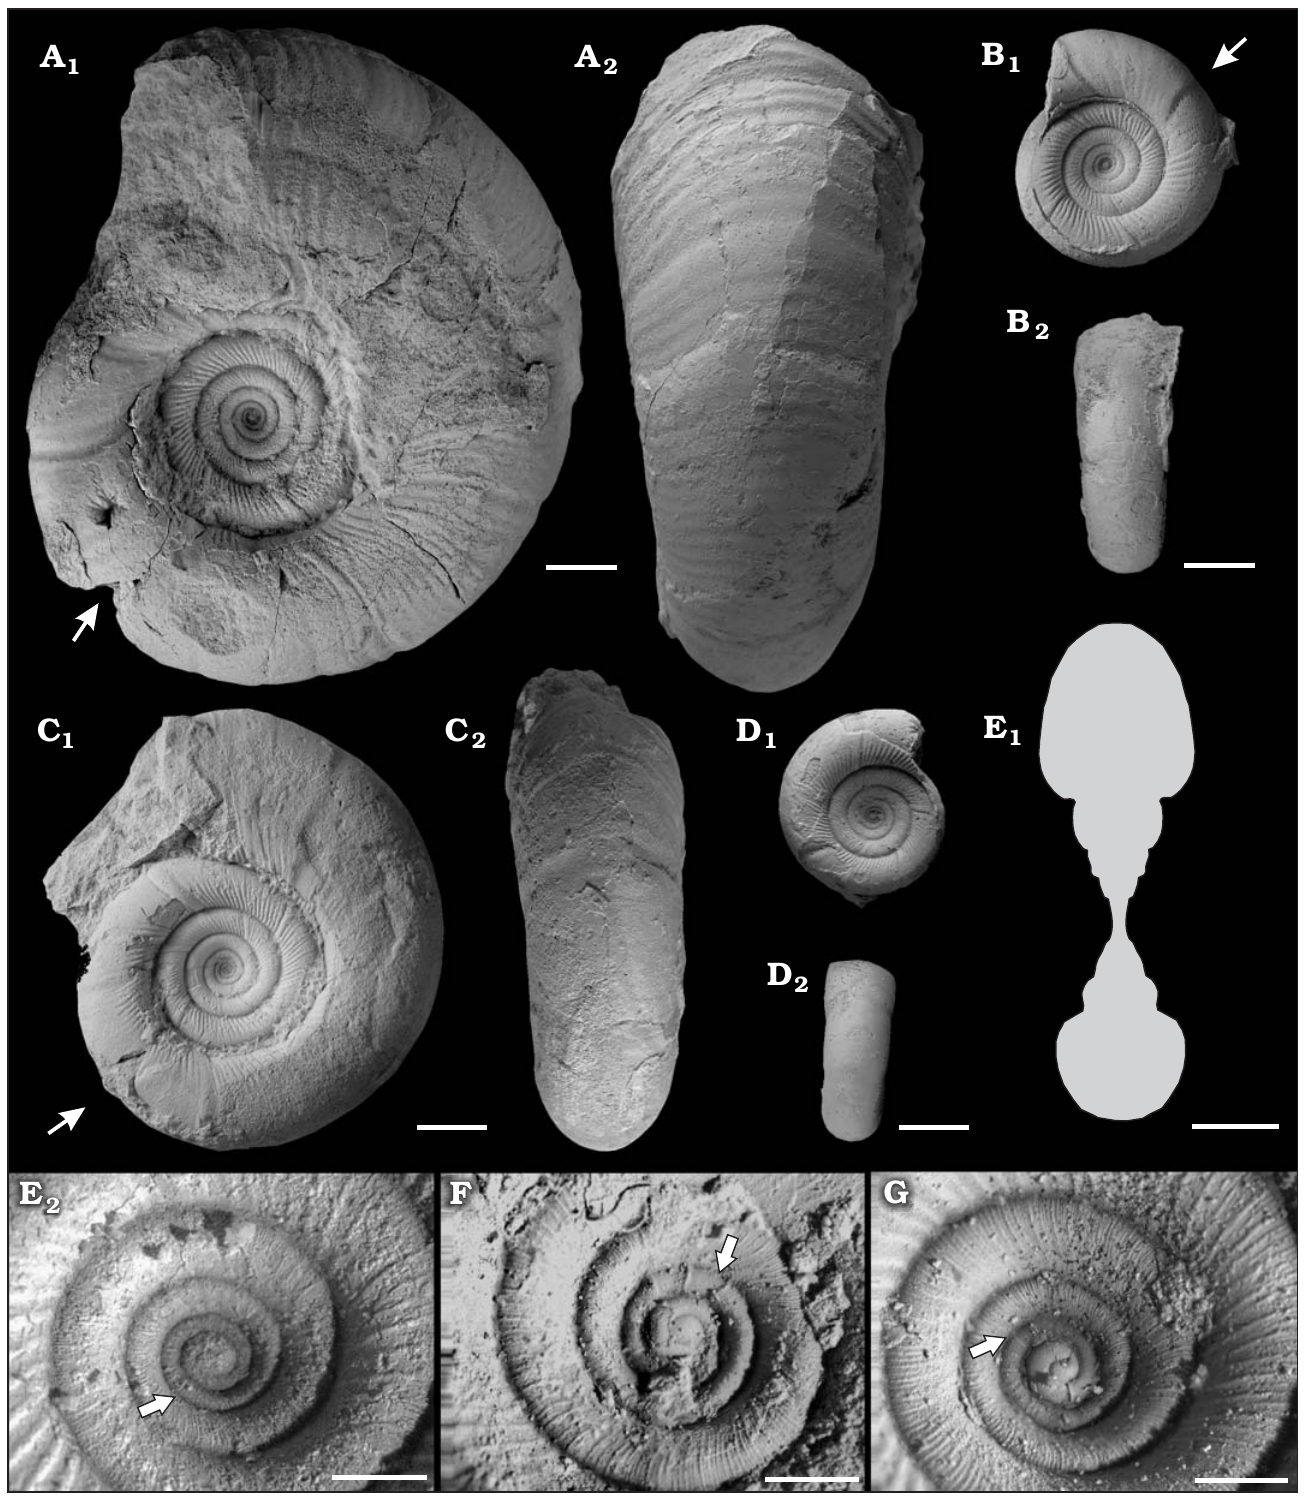
Fig. 4. The gaudryceratid ammonoid Gaudryceras submurdochi Raffi and Olivero sp. nov., early Campanian (Upper Cretaceous), Antarctica, from Rabot Formation, Redonda Point locality (A–D, F) and Hamilton Norte locality (E) and from Santa Marta Formation, Brandy Bay locality (G). A . CADIC PI 416, holotype, phragmocone and part of the body chamber in lateral (A 1 ) and ventral (A 2 ) views. B . CADIC PI 428, phragmocone and part of the body chamber in lateral (B 1 ) and ventral (B 2 ) views. C . CADIC PI 421, phragmocone and part of the body chamber in lateral (C 1 ) and ventral (C 2 ) views. D . CADIC PI 442, phragmocone in lateral (D 1 ) and ventral (D 2 ) views; the arrows mark the beginnig of the body chamber. E . CADIC PI 417, transversal section to a diameter of 57.5 mm (E 1 ), neanoconch ornamentation (E 2 ). F , G . Neanoconch ornamentation. F . CADIC PI 422. G . CADIC PI 431. The arrows point to major ribs in the neanoconch. Scale bars 1 mm, except E 2 , F, G 10